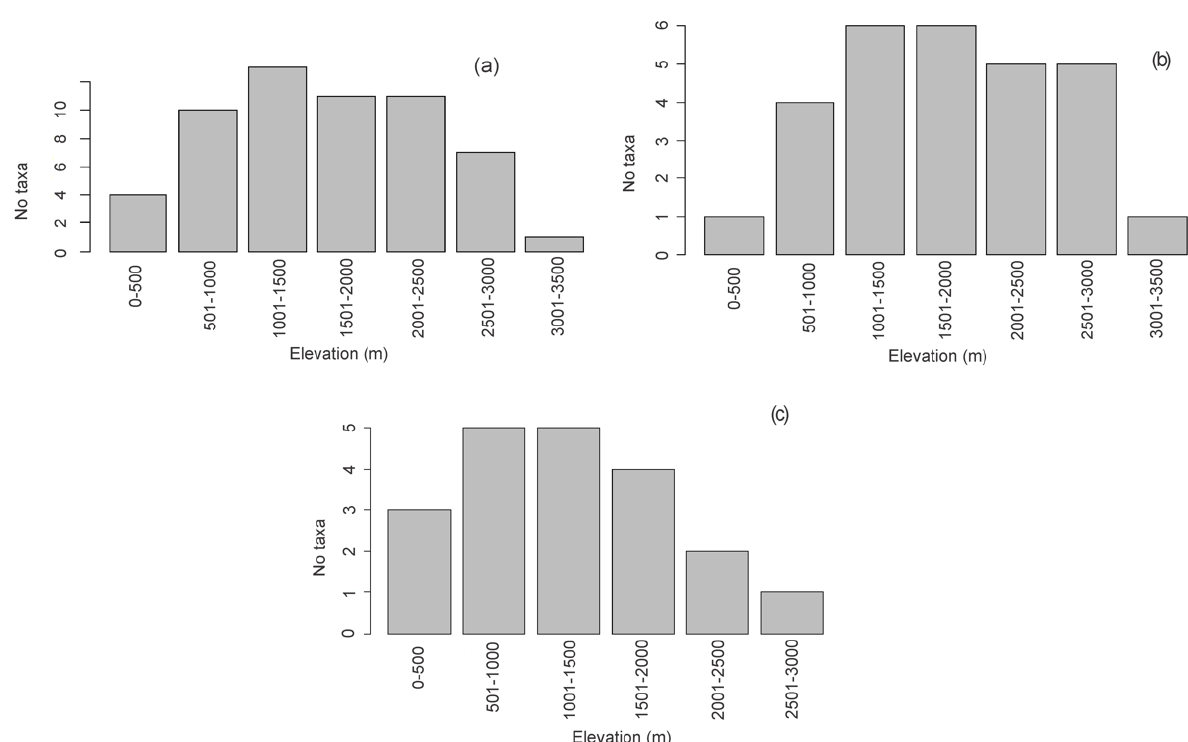
Figure 3. Number of taxa by elevation for ( a ) Laelia s.l., ( b ) Laelia s.s., and ( c ) Schomburgkia.